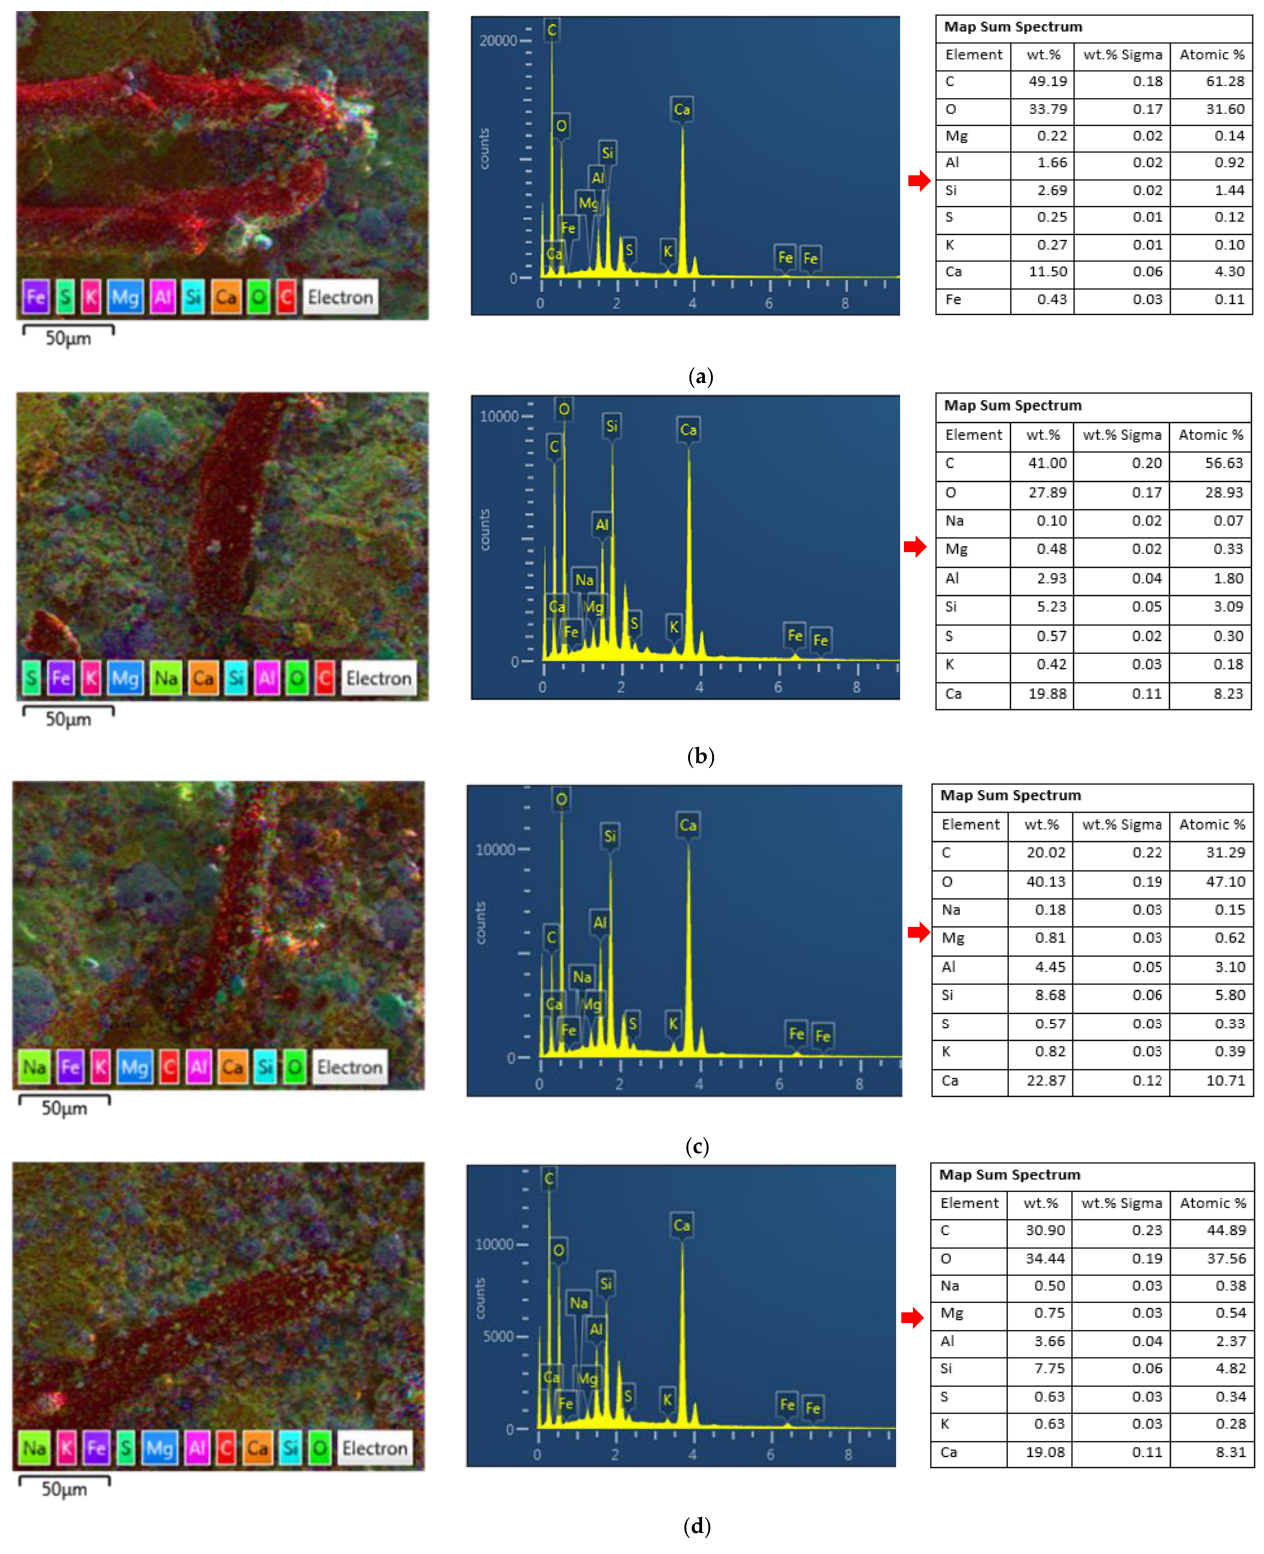
Figure 12. Mapping analysis of EDS spectra for 7-day specimens. ( a ) SF-0-60, ( b ) SF-5-55, ( c ) SF-10-50, ( d ) SF-15-45.